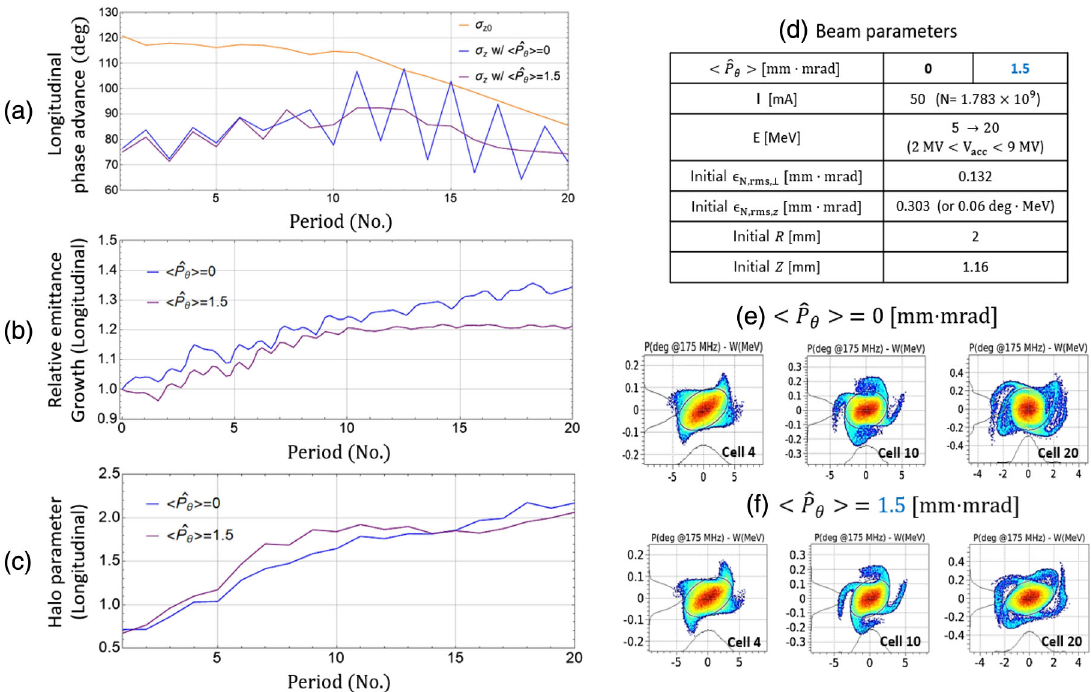
FIG. 11. (a) Longitudinal phase advances, (b) relative emittance growth, (c) halo parameter, and (d) beam parameters under the solenoid focusing lattice. Here, σ z 0 decreases from 120° to 90° as the beams are accelerated from 5 to 20 MeVover 20 periods. (e) and (f) show the phase (deg) · energy (MeV) plots of nonspinning and spinning beams, respectively. The resonance structures are clearly shown in both (e) and (f) to be independent of the canonical angular momentum of the beam. The initial transverse phase advances are σ 85 ° and σ 50 °, whereby there is no emittance exchange between the transverse and longitudinal ⊥ 0 ¼ ⊥ ¼ (deg) · energy (MeV) planes are clearly shown in both Figs. 11(e) and 11(f) to be independent of the canonical angular momentum of the beam.